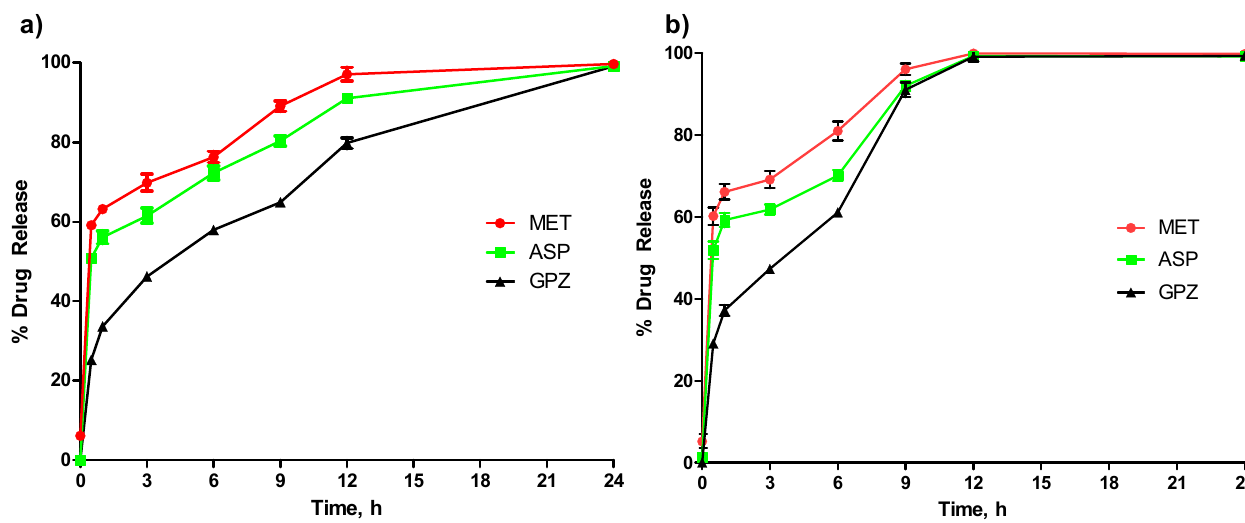
Figure 7. Analysis of in vitro drug release in the media resembling intrinsic pH 6.6. Three model drugs—MET, ASP, and GPZ—encapsulated in ( a ) alginate capsule and ( b ) MMT-enhanced alginate capsule ( n = 3, ± SD).